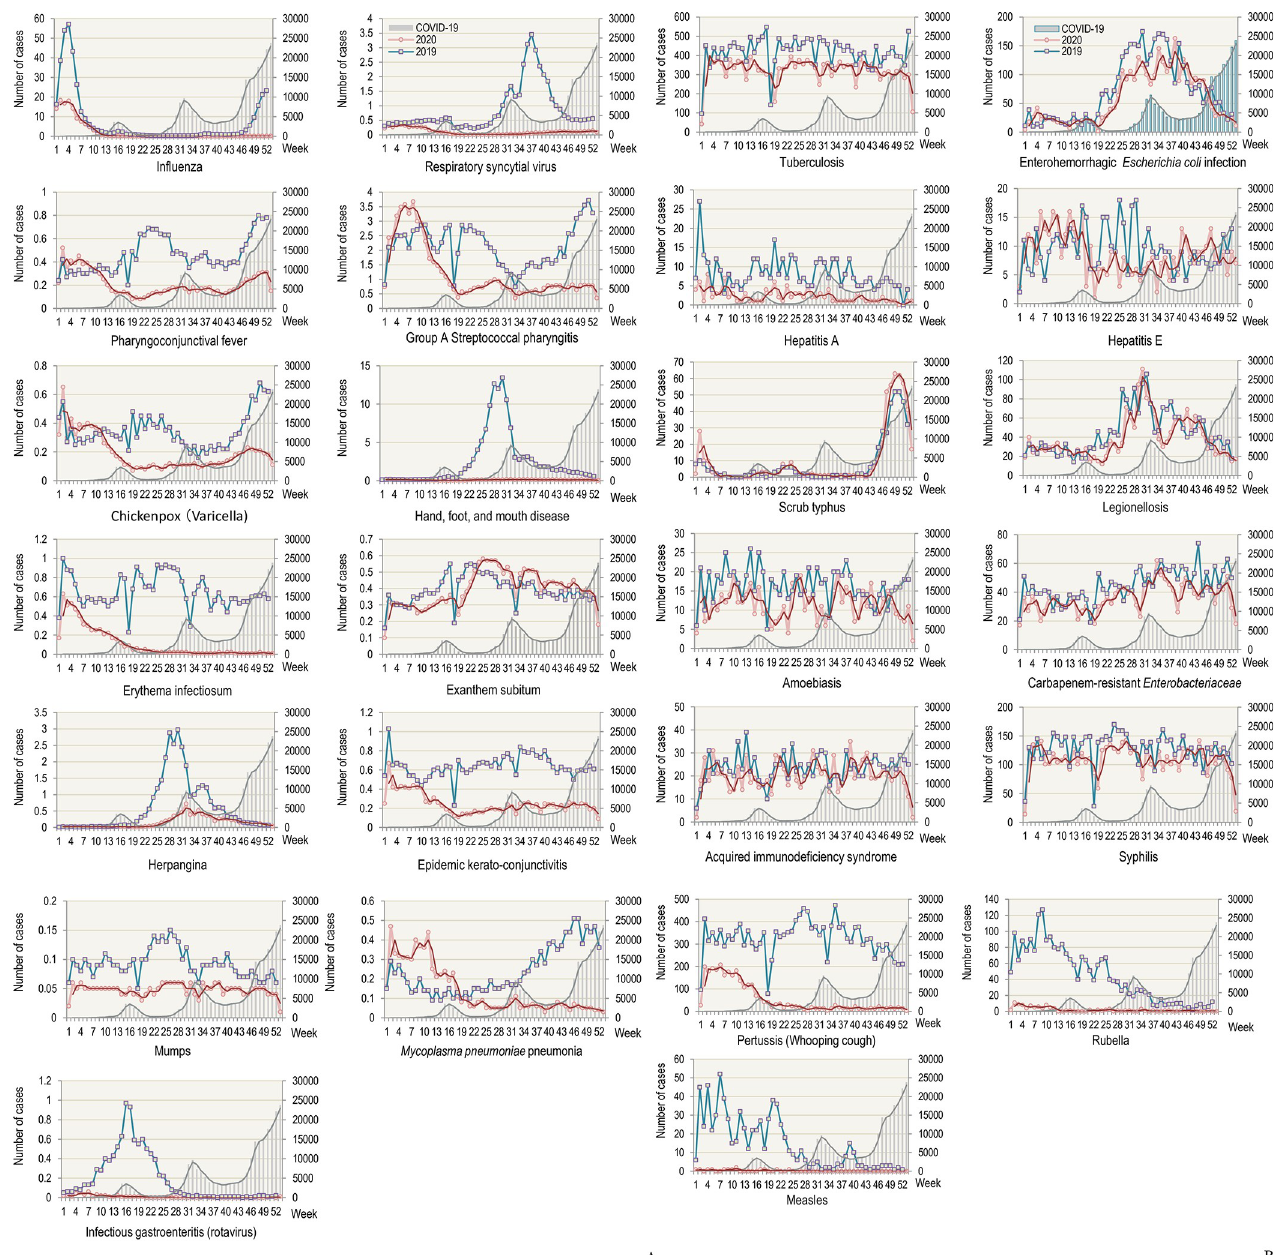
Fig 2. Current epidemic curves of common infectious diseases in 2020 compared with those in 2019. (a) Common infectious diseases under the national sentinel surveillance. (b) Common infectious diseases under the national notifiable disease surveillance. Each left vertical axis represents the number of patients referred to one medical facility per week per selected time point (a) or the total number of cases per week reported (b). Each right vertical axis and gray bars () indicate the total number of newly confirmed COVID-19 cases per week reported in Japan. The blue lines () indicate the 2019 epidemic curves. The scarlet thin lines () indicate the 2020 epidemic curve. The moving average lines were applied to the column graph of COVID-19 incidence (gray tick line) and to the incidence curve of 2020 (scarlet tick line) of each common infectious disease. The “week” along the x-axis indicates the epidemiological week. Data on COVID- 19 were obtained from surveillance data by the National Institute of Infectious Diseases in Japan [8]. Data on common infectious diseases were obtained from the Infectious Diseases Weekly Reports from the National Epidemiological Surveillance of Infectious Diseases by the National Institute of Infectious Diseases in Japan